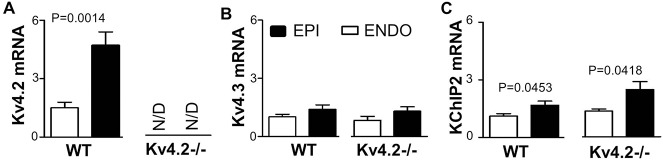
Kv4.2, Kv4.3 and KChIP2 mRNA expression level in ENDO and EPI tissue sample from left ventricular free wall of WT and Kv4.2-/- hearts.Relative gene expression of voltage-gated K+ channels in ENDO and EPI tissues of WT (n = 6) and Kv4.2-/- (n = 6) hearts were measured by qtPCR and analyzed using the ∆∆Ct method with normalization to GAPDH, which did not change between samples. The qtPCR protocols involved 35 cycles for all reactions. All the primers were tested with by generating standard curves to measure probe efficiency and both meting curves and electrophoresis were utilized to confirm single PCR products. (A) This panel shows the estimated Kv4.2 mRNA expression levels detected in WT hearts. No specific Kv4.2 PCR product was detected in Kv4.2-/- hearts after 35 cycles (i.e. not detected, ND). Note the large EPI to ENDO gradients in the WT hearts, as expected. (B) Kv4.3 mRNA expression in both WT and Kv4.2-/- hearts showing no measureable gradient, although trends existing with more in the EPI than ENDO. (C) KChIP2 mRNA showing transmural heterogeneity (EPI>ENDO) in both the WT and Kv4.2-/- hearts.